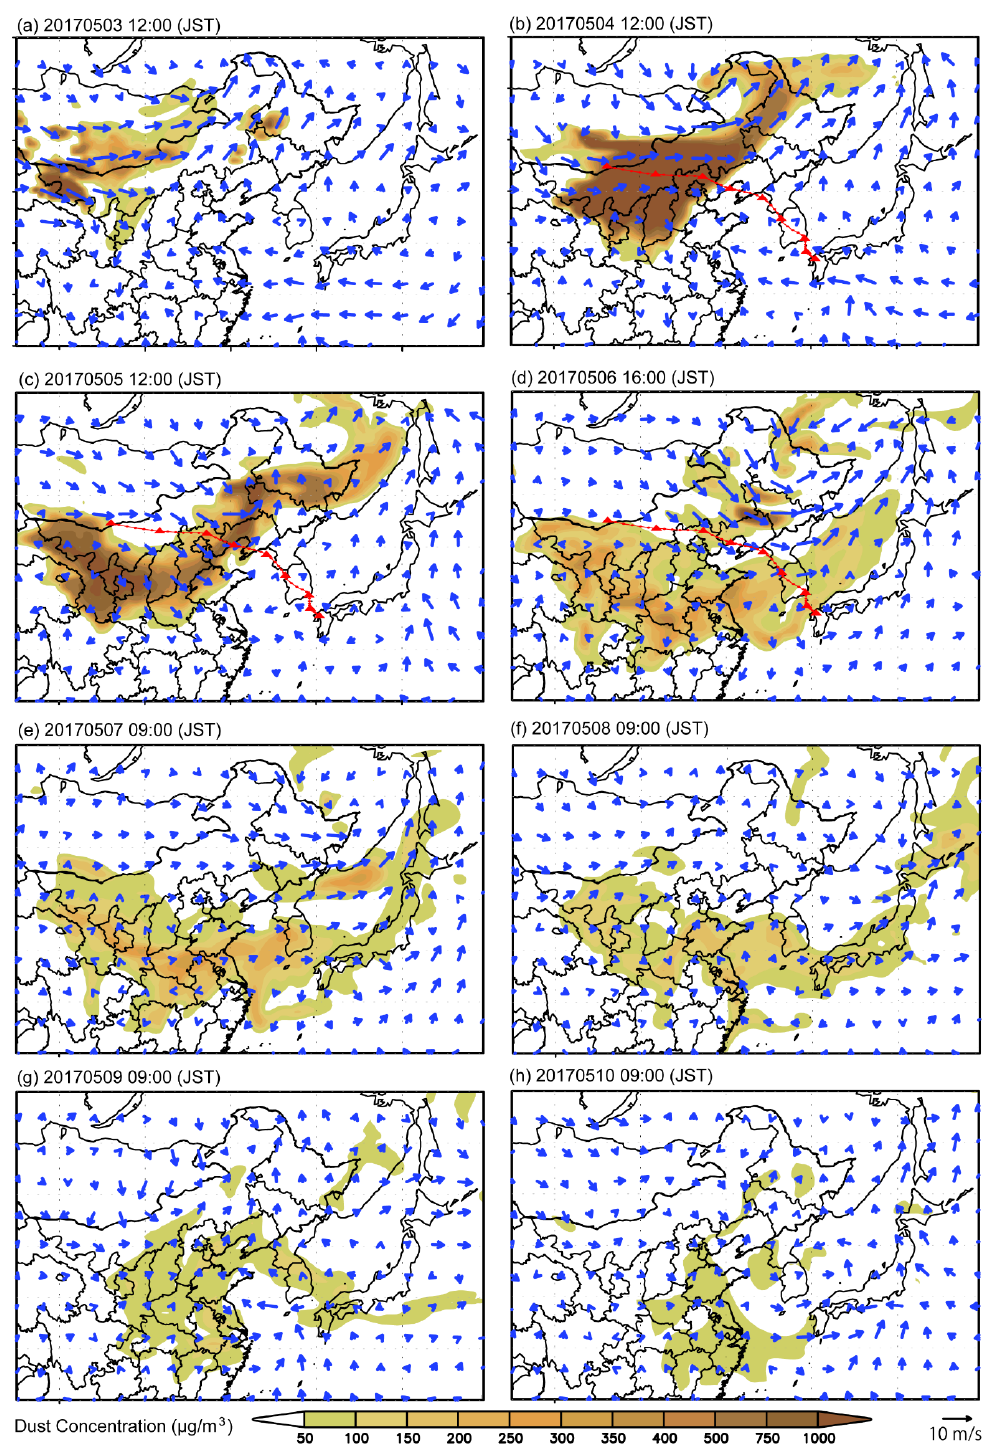
Figure 3. Simulated daily horizontal distributions of dust concentrations (shades) and wind vectors (blue vectors) at the first vertical level (z = 50 m) of the model on each day ( a – h ) between 3 May and 10 May 2017 (JST). The red lines with triangle markers (every 6 h) in ( c ) and ( d ) show the 48 h backward trajectory from Fukuoka, at 20:00, on 6 May 2017